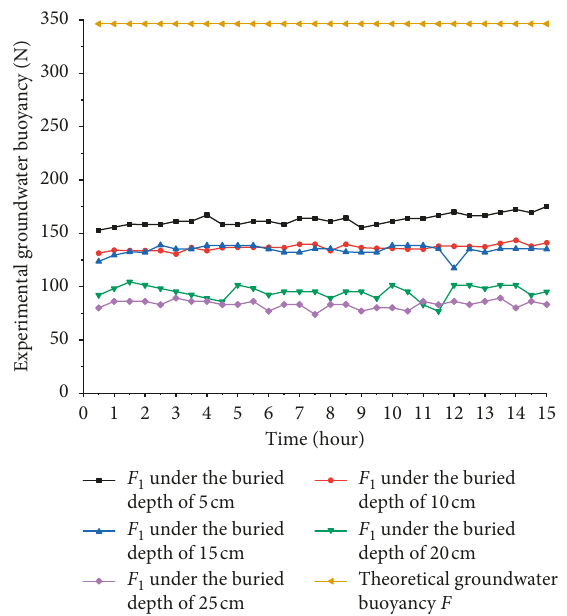
Figure 11: Variation of proportion coefficient Ψ with the action time of groundwater pressure under different buried